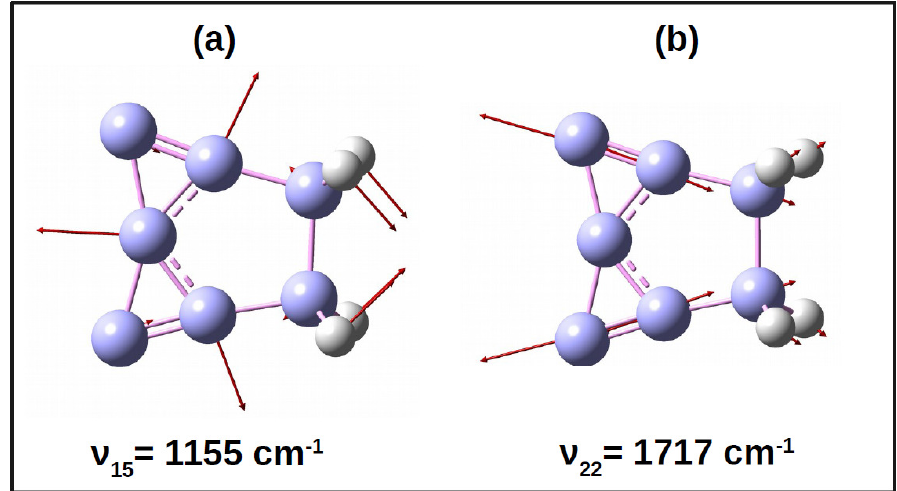
Figure 4. Schematic representation of the ( a ) in-plane ring deformation (Q 15 ) and ( b ) C=C stretch (Q 22 ) vibrational modes of C 7 H 4 . Harmonic frequencies obtained using B3LYP/6-311++G(d,p) level of theory are also